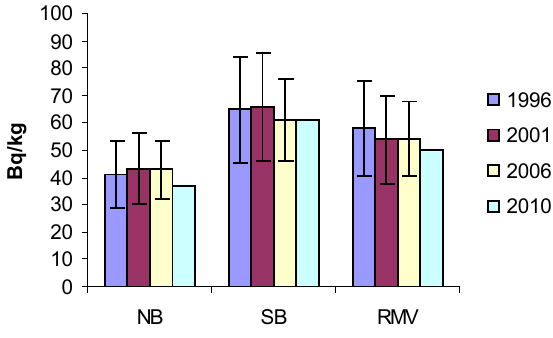
Figure 4: Content of 232 Th activity concentration in soil from different regions